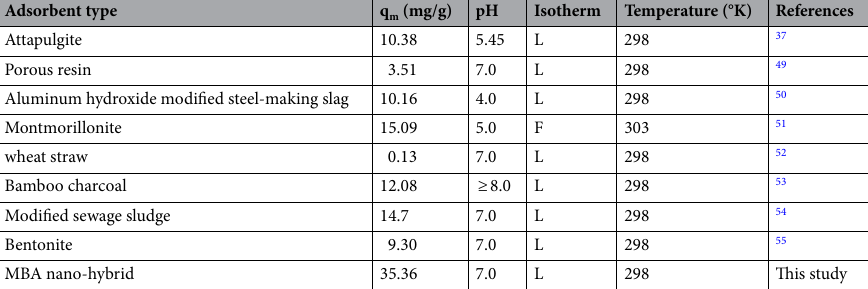
Table 3. Adsorption of Cd(II) ions from aqueous solutions by different